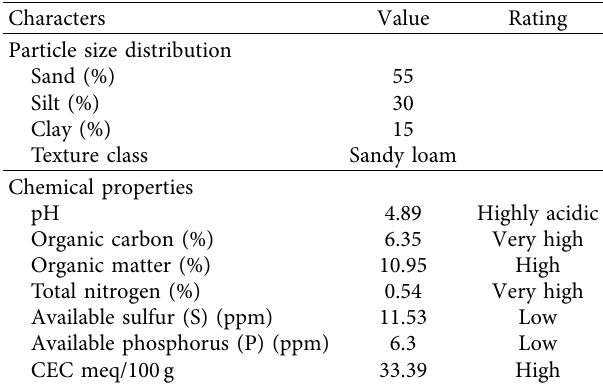
Table 2: Before planting, the soil’s physicochemical characteristics at the Gitilo Dale location in the Horro